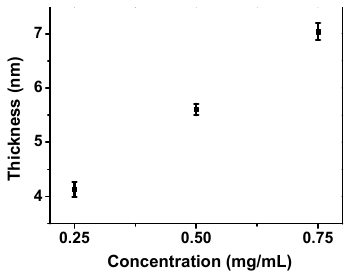
Figure 2. The thickness versus the corresponding concentration of PSBMA. The films were prepared by spin-coating at 4500 rpm for 45 s.